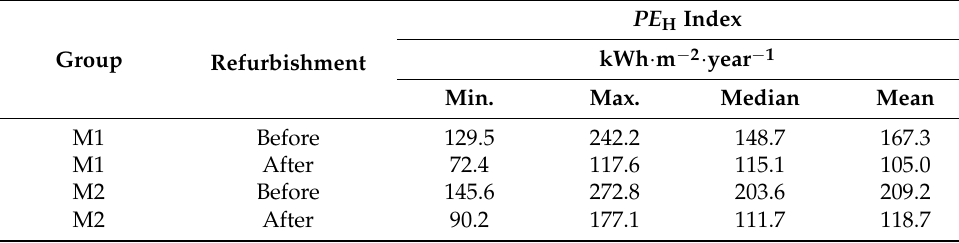
Table 10. Values of the PE H [kWh · m − 2 · year − 1 ] in group M1 and M2.